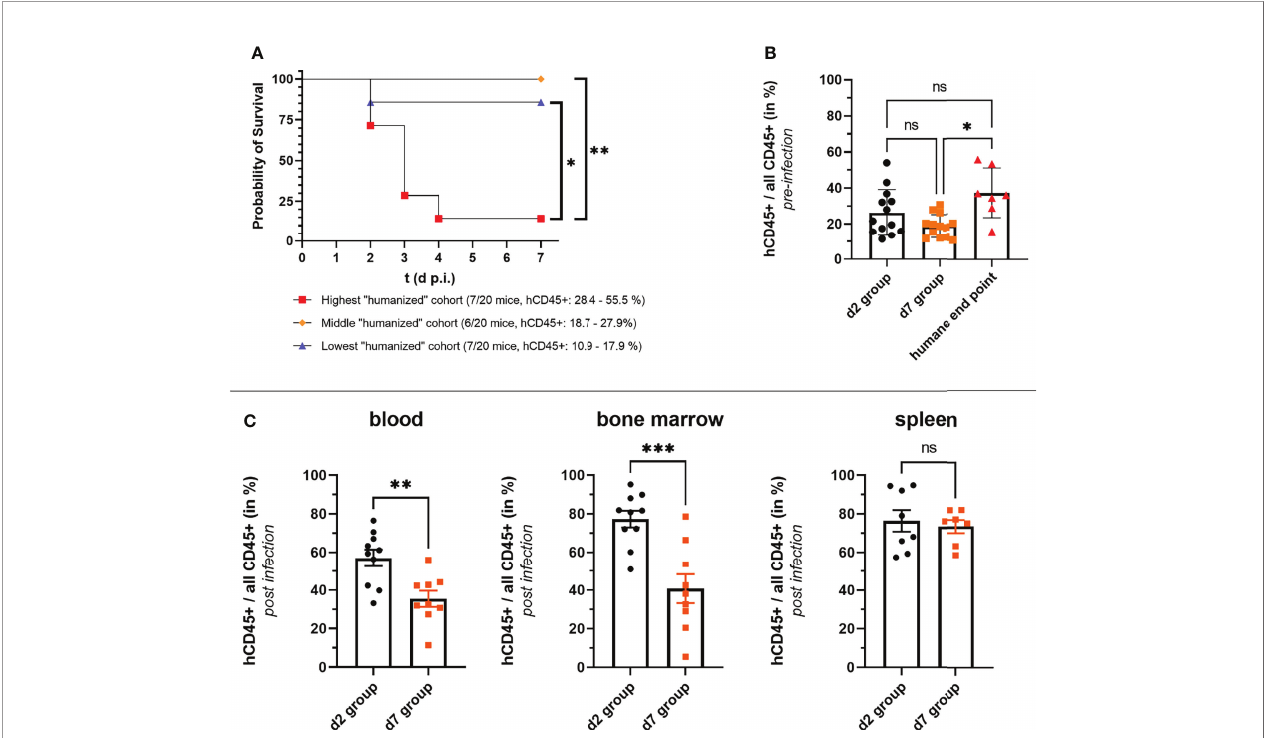
FIGURE 3 | Correlation of rate of humanization (hCD45+ cells/all CD45+ cells) and severity of infection. (A, B) The numbers of human and murine CD45+ cells were determined by fl ow cytometry before mice were infected with S. aureus . (A) HuNSG mice which either reached the humane end point of the experiment or were assigned to the day 7 p.i. group were ordered dependent on their rate of humanization into three groups. All but one mouse that reached the humane end point was in the group with the highest rate of humanization as depicted in the survival graph. Statistical signi fi cance was tested with the Log-rank (Mantel-Cox) test. (B) The rate of humanization of each huNSG mice in the experiment is depicted according to the outcome/end point of the experiment. Surviving mice were either assigned to the day 2 or day 7 p.i. end point groups, while the seven huNSG mice which reached the humane end point prematurely between day 2 and day 7 p.i. were assigned to the “ humane end point group ” . (C) The rate of humanization at the end of the infection experiment was additionally measured by fl ow cytometry for the d2 and d7 groups in blood, spleen and bone marrow. Statistical signi fi cance was tested by Kruskal-Wallis with Dunn ’ s post-test (ns, not signi fi cant, *p ≤ 0.05, **p ≤ 0.01, ***p ≤